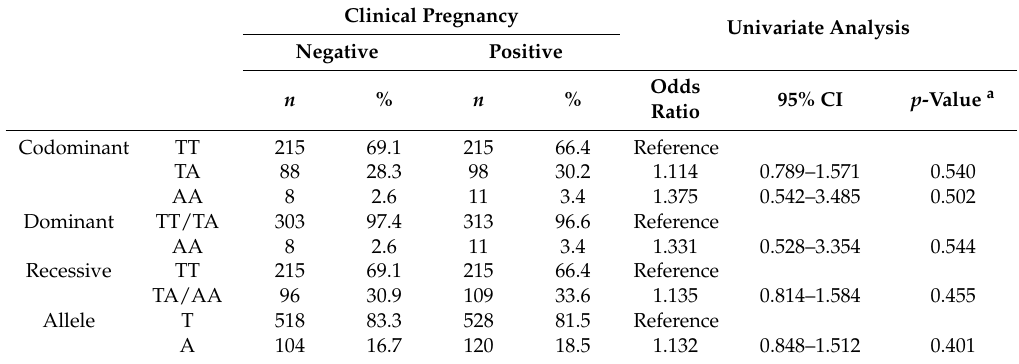
Table 6. Frequencies of AMHRII IVS1 +149 T > A (rs2272002) polymorphism among women with different IVF outcome.